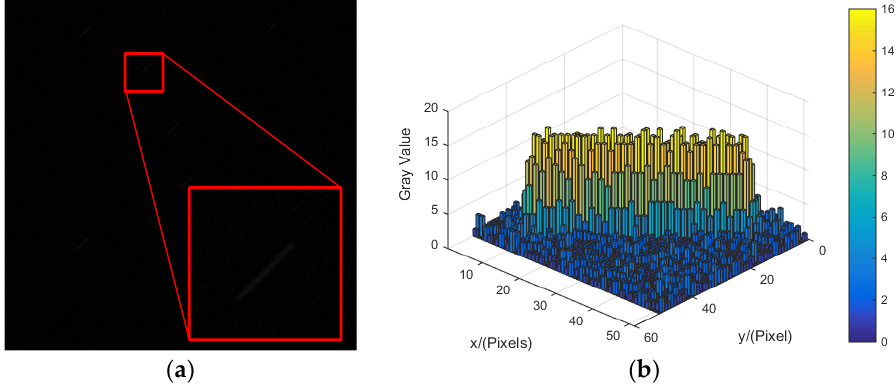
Figure 8. The simulated blur star image and its energy distribution. ( a ) The simulated blur star image. ( b ) The energy distribution of the blur star image. The simulated output of gyroscope is based on